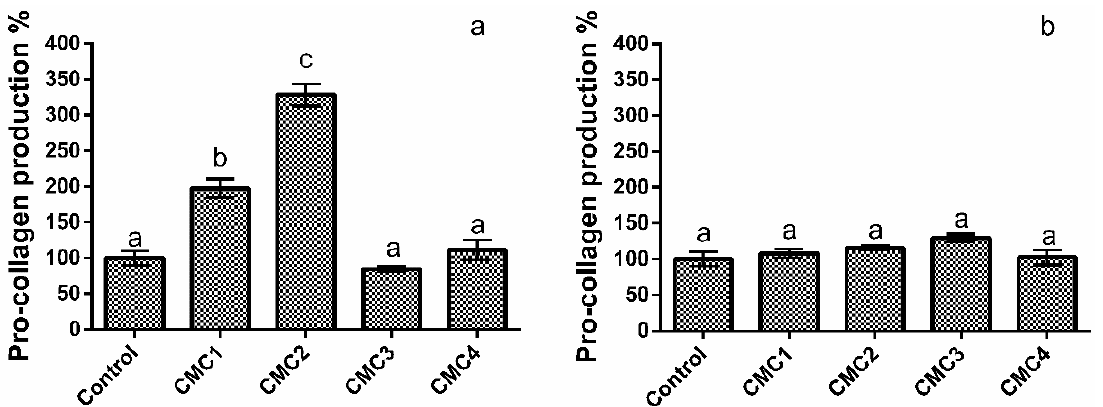
Figure 5. Pro-collagen I α I relative percentage of production in the presence of different CMC samples relative to the basal level (control). ( a ) Intracellular; ( b ) extracellular. Different letters represent the statistically significant differences ( p < 0.05) found between conditions.